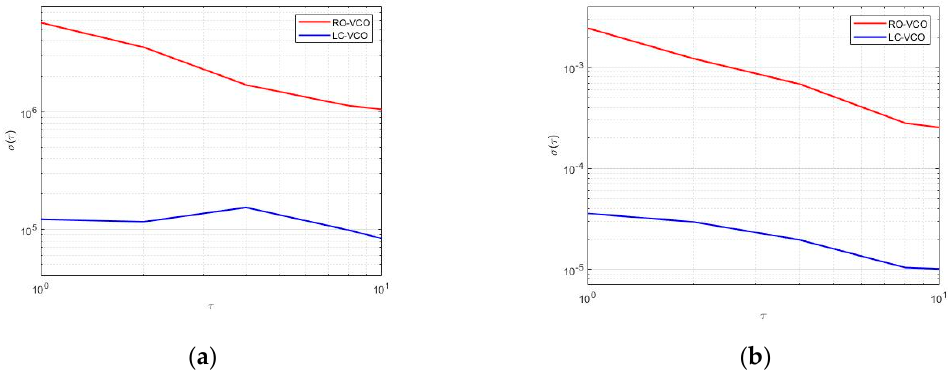
Figure 11. Allan deviation of ( a ) frequency and ( b ) amplitude for RO-VCO ( red line ) and LC-VCO ( blue line ) calculated in typical condition at the same oscillation frequency.